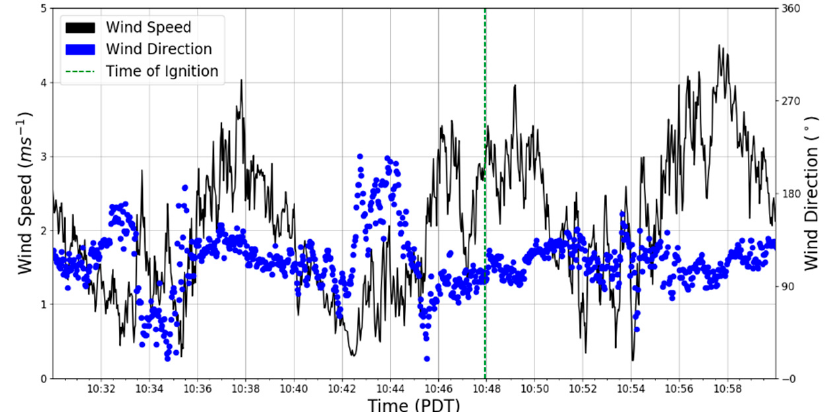
Figure 4. Time series of 7-m AGL wind speed and wind direction on 22 June 2012 observed using the CSU-MAPS tower. Ignition time is indicated by the vertical green dashed line.